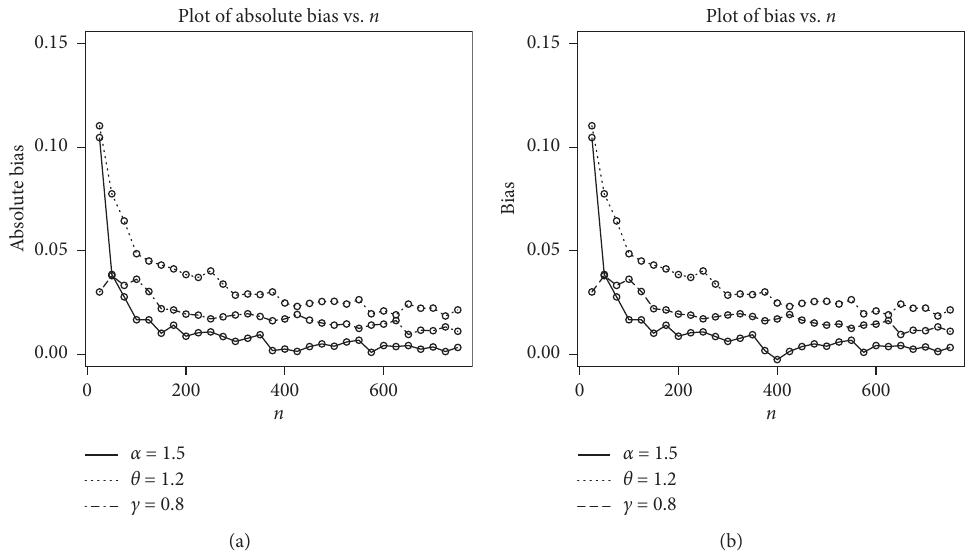
Figure 7: MLEs and MSEs plots of the NGE-Weibull distribution for α � 1 . 5, θ � 1 . 2, and c � 0 .